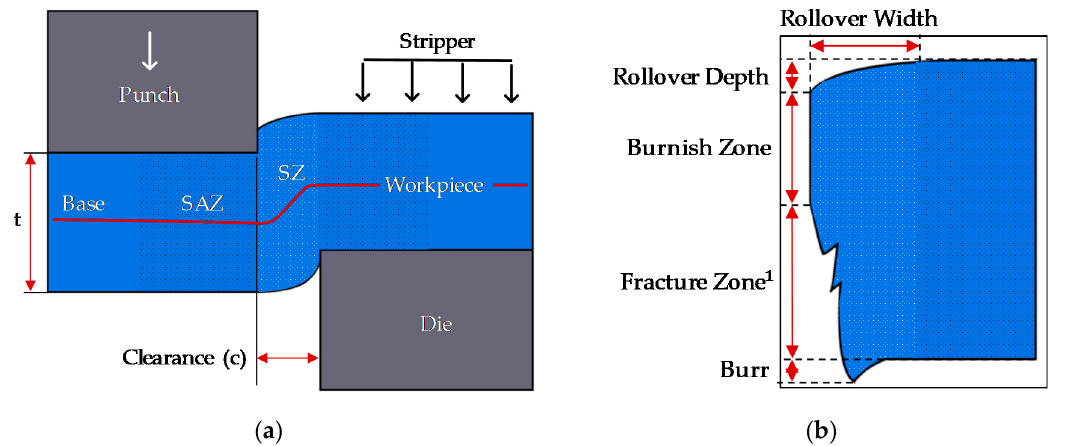
Figure 1. ( a ) Schematic of the blanking process; ( b ) illustration of the sheared edge profile, consisting of rollover region, burnish zone, fracture zone, and burr. 1 Fracture zone value excluding burr.